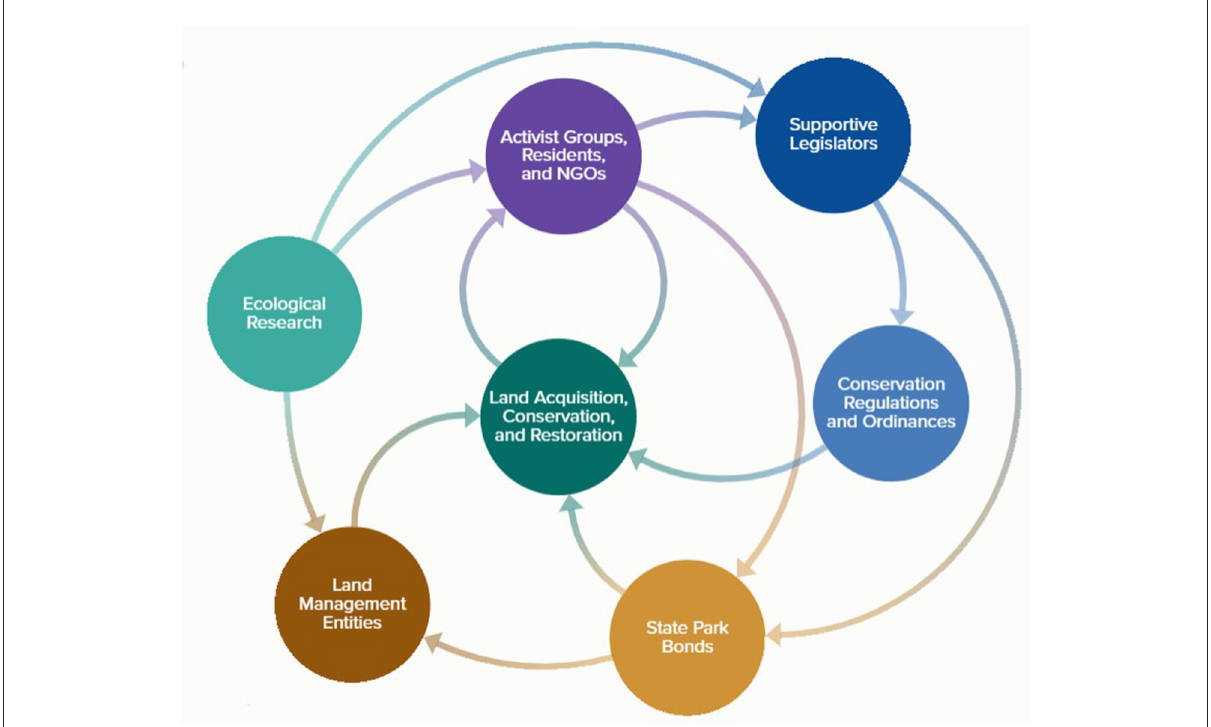
FIGURE3 The virtuous cycle of land acquisition in the Santa Monica Mountains, showing the relationship between governmental officials and organizations, NGOs, and other stakeholders involved in open space prioritization and acquisition. Ecological research informs conservation priorities and educates stakeholder groups. Local activists and NGOs rally public support and identify threats and opportunities. NGOs endorse and support politicians and bond measures. Bond measures fund grants for local land acquisition and support management. Officials at multiple levels of government draft laws and bond measures for land protection. Multiple agencies own and manage land. A few purchase and set aside open space for public use. Access to open space inspires activists and NGOs to conserve more. See Table 1 for detail on each